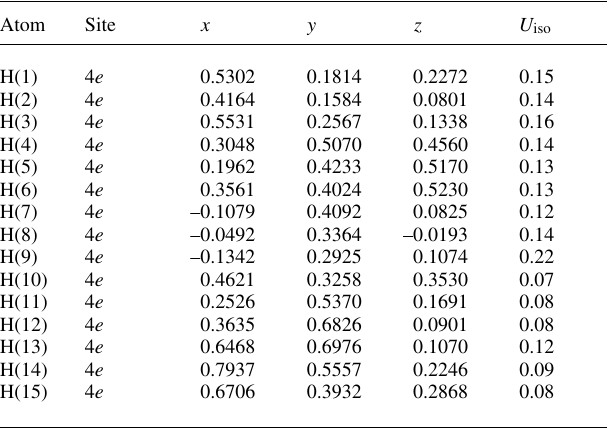
Table 2. Atomic coordinates and displacement parameters (in Å 2 ) .